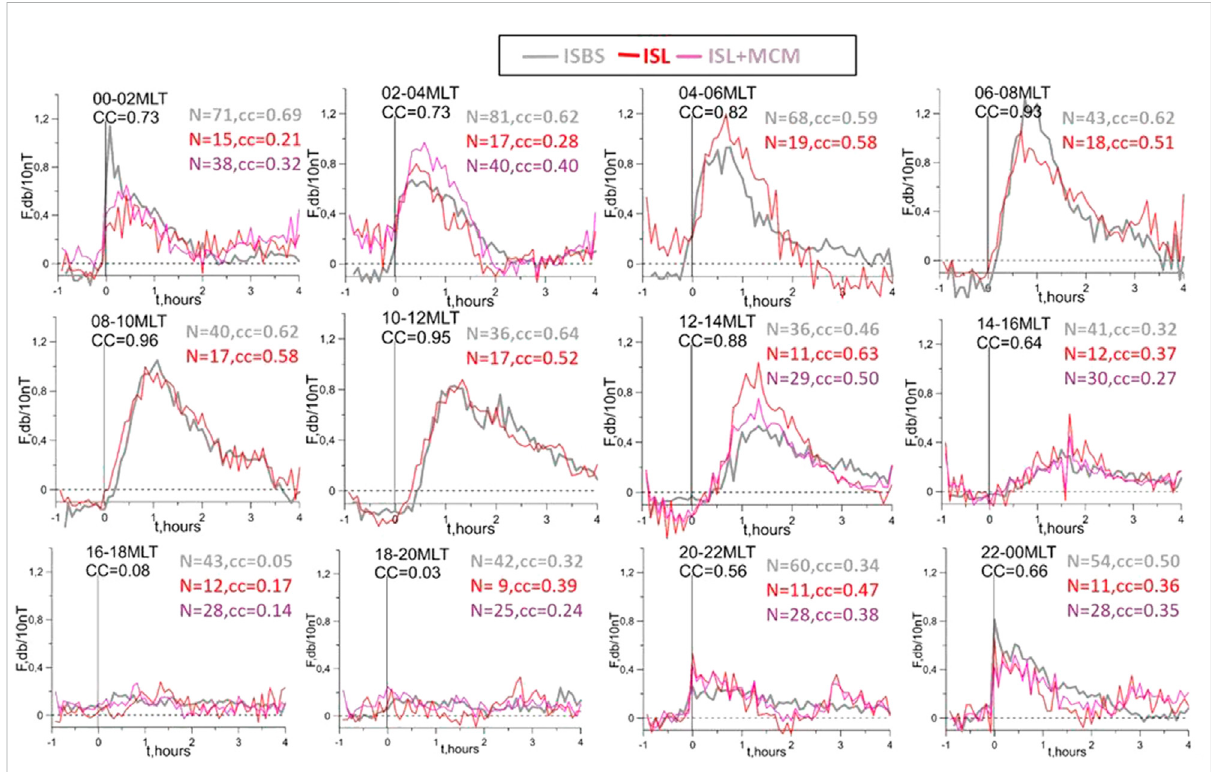
FIGURE 3 Summaryofresponsefunctionsreconstructedforisolatedsubstorms(at~67 o CGL)andforactiveperiod(at~64 o )inallMLTbins.BesidesNand ccinthelegend(thesameasinFigure2)thecorrelationcoef fi cientsbetweenLPFsforiSBSandforactivetimesarealsoshownnearthetopofvertical line at t =